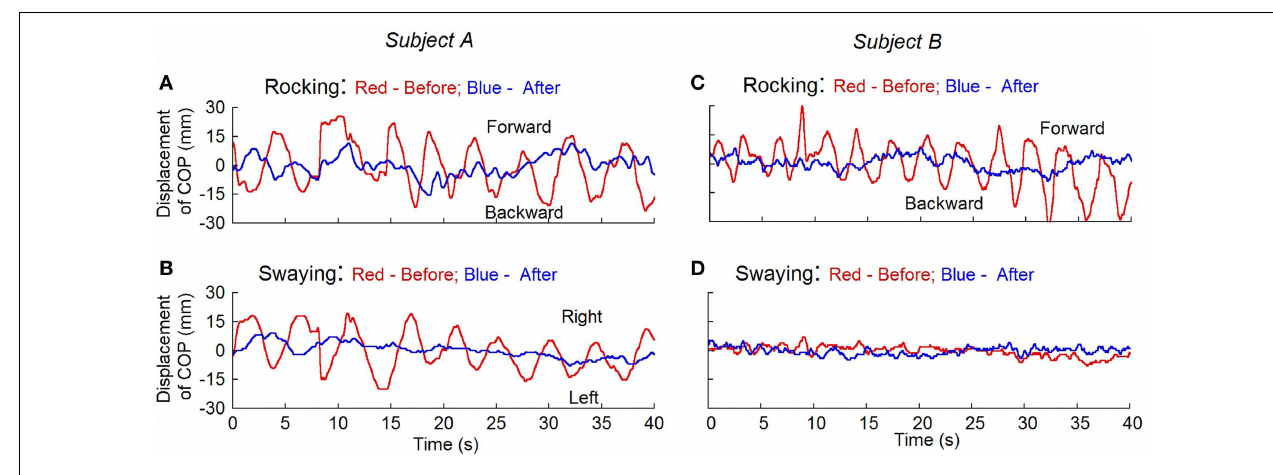
rocking and swaying whereas subject B mainly had rocking. After treatment, the rhythmic oscillations present before the treatment